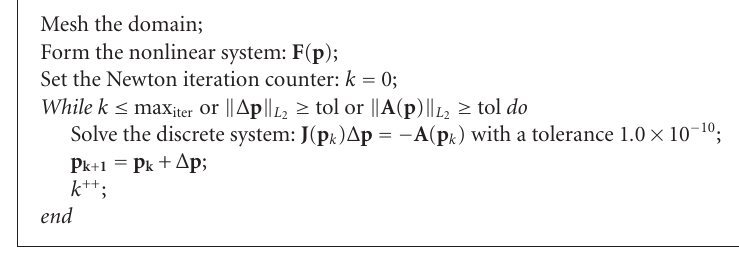
Algorithm 3 . 1 . Quasi-Newton-Krylov